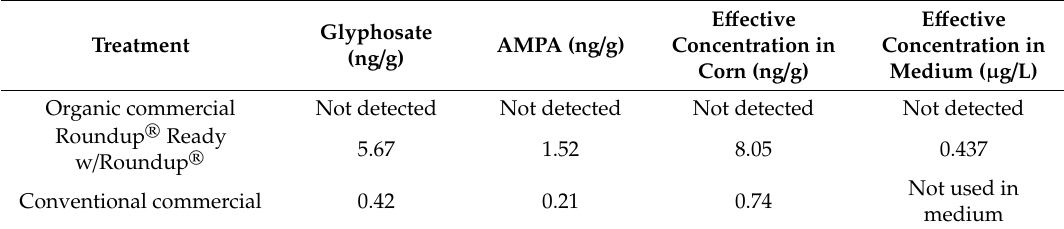
Figure 2. Effect of diets containing different types of corn on reproductive behavior. ( a ) Proportion of pairs mating (± std. err.), primarily controlled by females, in Experiment 2, of flies reared on different diets as adults. ( b ) Amount of time spent mating (± std. err.) in Experiment 3, which varied both larval ( ● ) and adult ( △ ) diets independently. ( c ) Amount of courtship by males (± std. err.) in Experiment 3 depending on larval ( ● ) and adult ( △ ) diets. Table 1. Glyphosate analysis for three types of